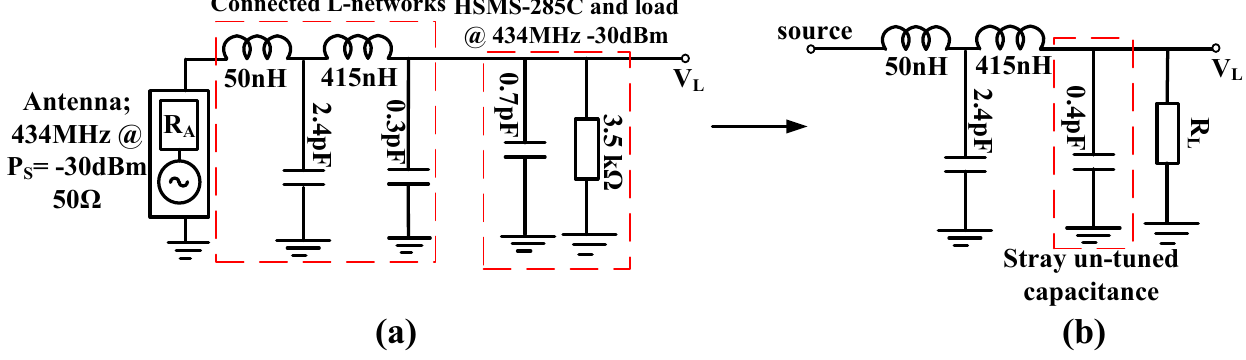
Figure 11. Impedance diagram of broadband RF power converter; ( a ) Broadband match around 434 MHz with loaded Q of 2.7, ( b ) Resultant impedance matching network with un-turned capacitance of 0.4 pF.